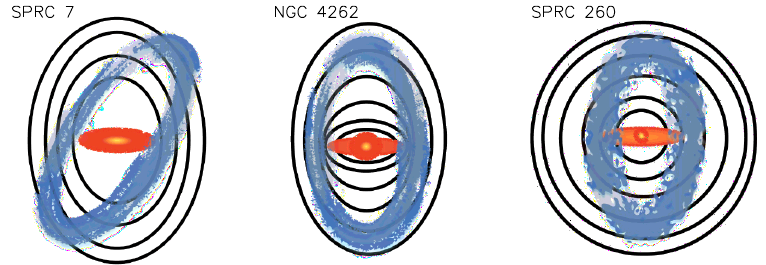
Fig. 3. Distribution of the dark halo gravitational potential (contours) according to the numerical calculations for the galaxies considered. The central disk and the polar ring are shown